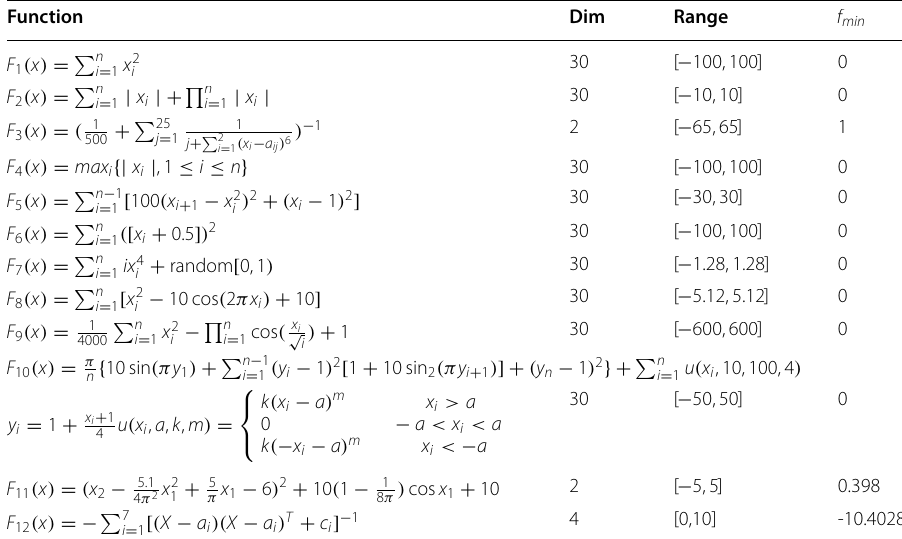
Table 1 12 benchmark